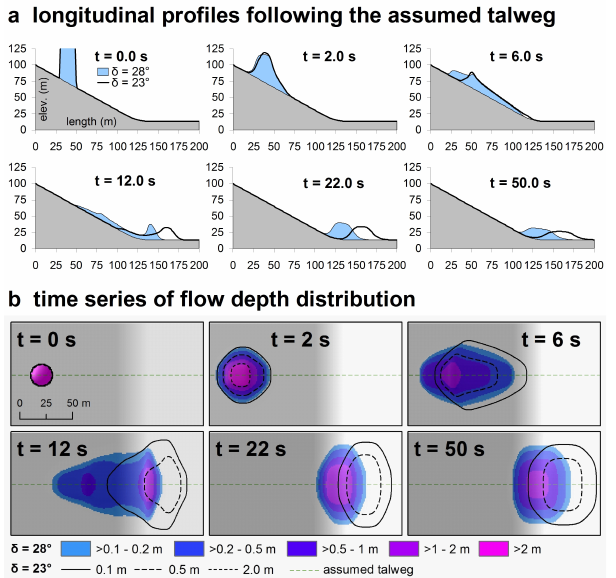
Fig. 5. Granular flow over an inclined surface running out into a horizontal plane with φ = 30 ◦ and δ = 23 ◦ and 28 ◦ , respectively: (a) longitudinal profiles, flow depth 15-fold exaggerated compared to terrain height; (b) flow depth maps (colours for δ = 28 ◦ and con- tour lines for δ = 23 ◦ ). The shorter travel distance with δ = 28 ◦ is